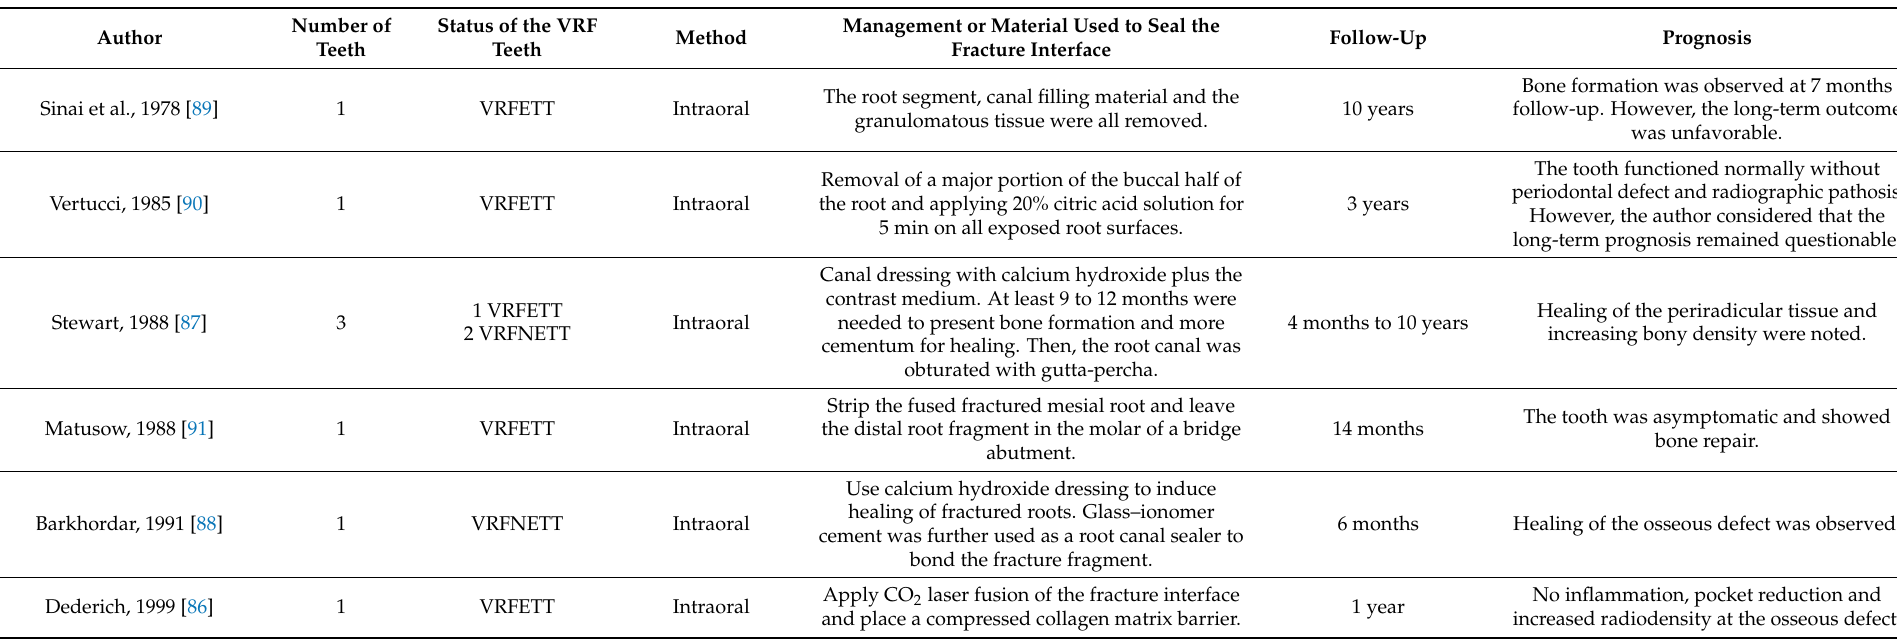
Table 4. Research regarding the application of CO 2 laser, intracanal medication or removing the fracture fragment in treating VRFs.